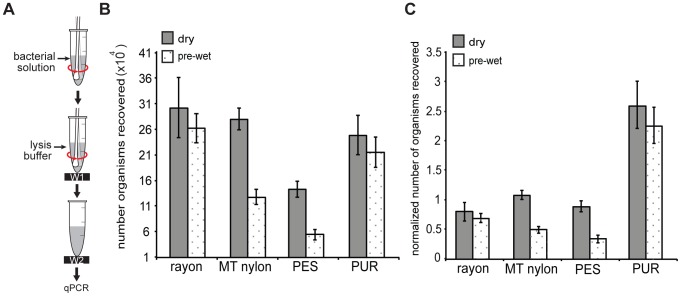
Organism recovery for high-volume samples.(A) Schematic of the experimental set up. Either a dry or pre-wet swab was dipped into 1 mL ∼106 CFU/mL S. aureus solution (equivalent to 6×106
ldh1 copies/mL, as measured by qPCR) and agitated by 10 second 1 Hz side twirl. The swab was then inserted into 128 µL lysis buffer, agitated by 10 second 1 Hz side twirl, and removed. (B) Comparison of the absolute number of organisms recovered for dry and pre-wet swabs. Absolute organism recovery was reported (rather than %) since the uptake of sample volume was different for each swab; absolute recovery was calculated using Equation 4 in the text. In all cases, recovery was larger than would be expected based on swab volume and sample concentration by colony counts due to presence of multiple target copies per CFU. (C) The number of organisms recovered from each swab from panel (B) normalized by the number of organisms expected based solely on the sample concentration and volume capacity of the swab (estimated number of organisms collected by the swab  =  swab volume capacity (µL) x bacterial stock concentration (copies/µL from qPCR)).